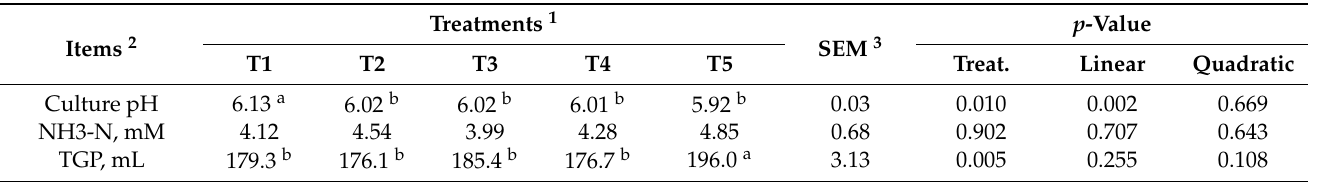
Table 6. The pH value, Ammonia-N and CO 2 gas production during the in vitro digestion and fermentation for dietary treatments with different levels of sprouted barley.